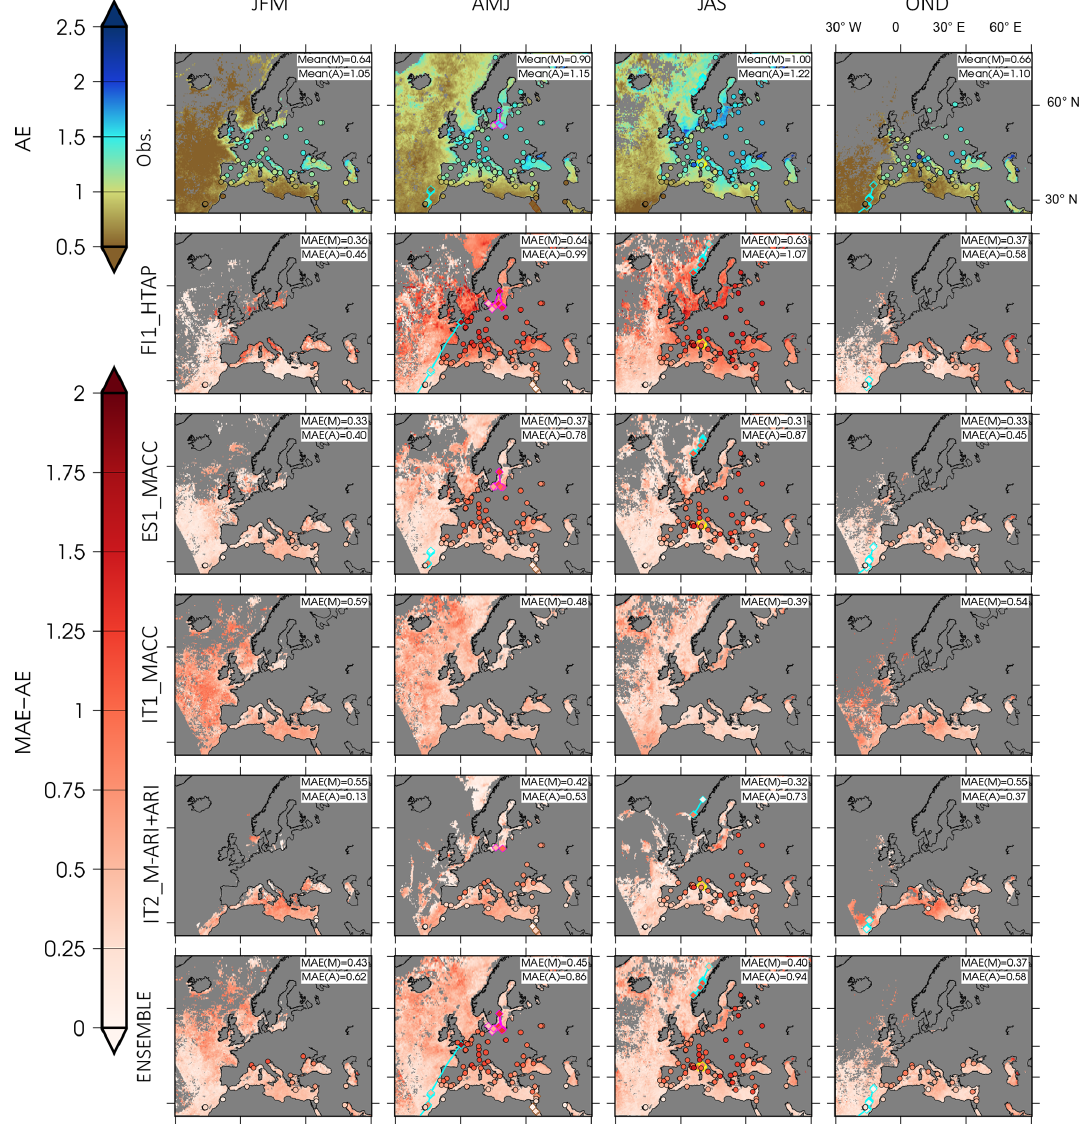
Figure 6. The same as Fig. 5 for the MAE